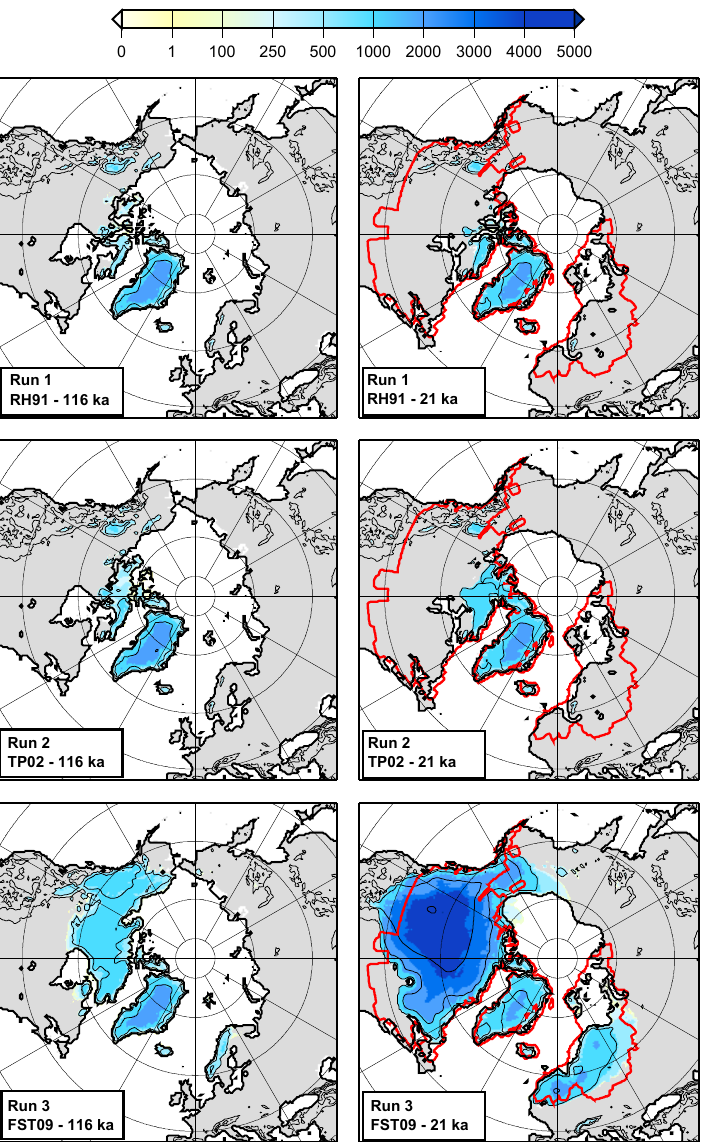
Fig. 1. Simulated ice thickness (in meters) at 116ka (left panels) and 21 ka (right panels) produced by the three standard fully coupled experiments with the RH91 (run 1, top panels), TP02 (run 2, middle) and FST09 (run 3, bottom) PDD models. Thick black lines represent the coastline and thin black lines display the iso-contours of surface elevation (from 1000 to 5000 m). The thick red lines in the right panels represent the areal extent of the ICE-5G LGM ice sheets (Peltier,